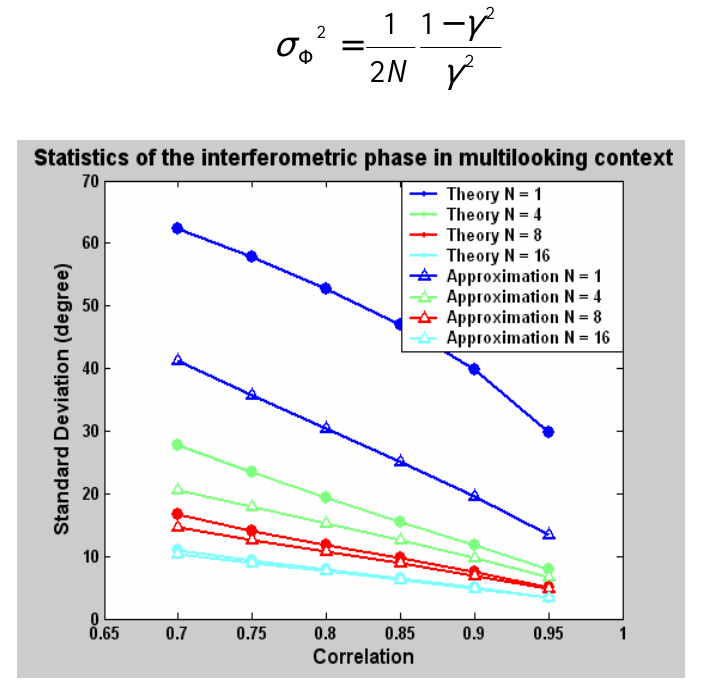
Figure 4. Statistics of the interferometric phase in multilooking